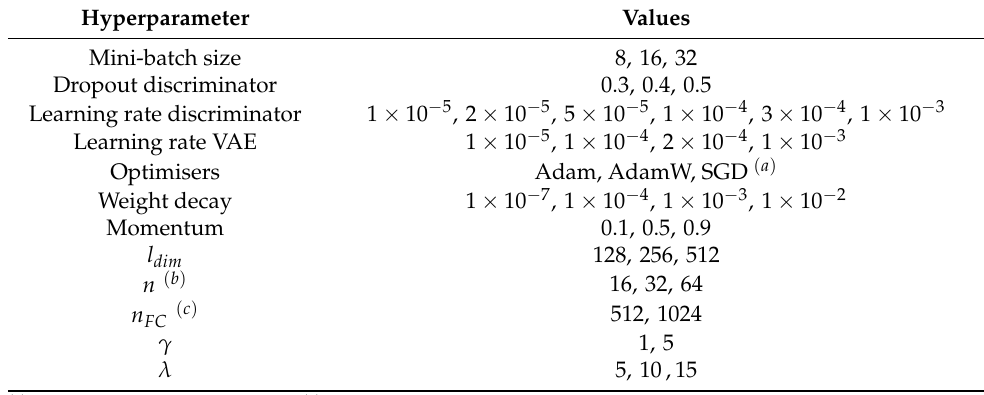
Table 2. List of values used for hyperparameter optimisation in the SSL model.